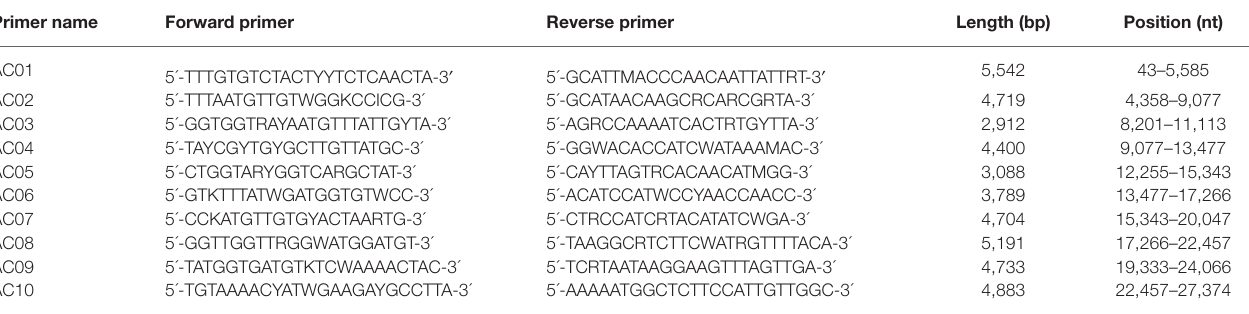
TABLE 1 | List of human alphacoronavirus universal primers (AC primer